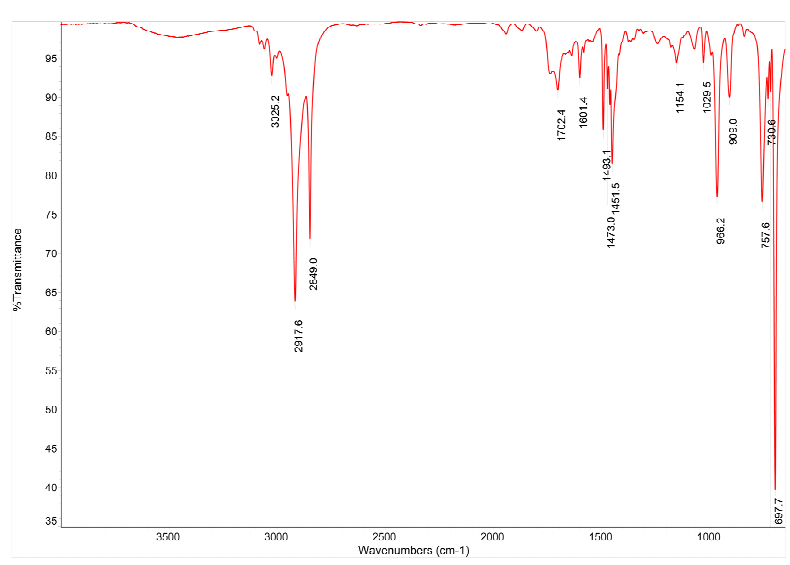
Figure A1. FTIR spectrum for the SB-B commercial coating.